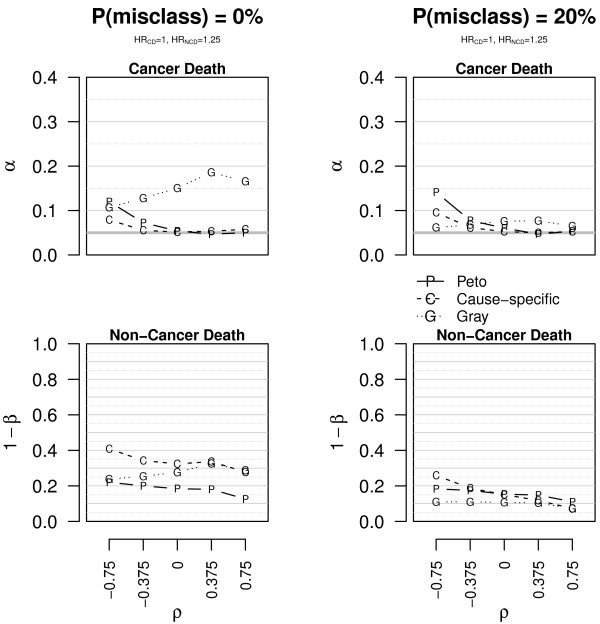
Empirical size and power of the tests in scenario 2. Empirical size (α) and power (1 - β) of the tests for CD and NCD in scenario 2 (HRCD = 1, HRNCD = 1.25). The data are simulated without censored observations. The plots on the first line concern CD, those on the second line NCD. The plots on the left are for data with correct causes of death (P(misclass) = 0%), those on the right for data with 20% of misclassified causes of death (P(misclass) = 20%). The bold grey horizontal line corresponds to the 0.05 level and ρ to the correlation.